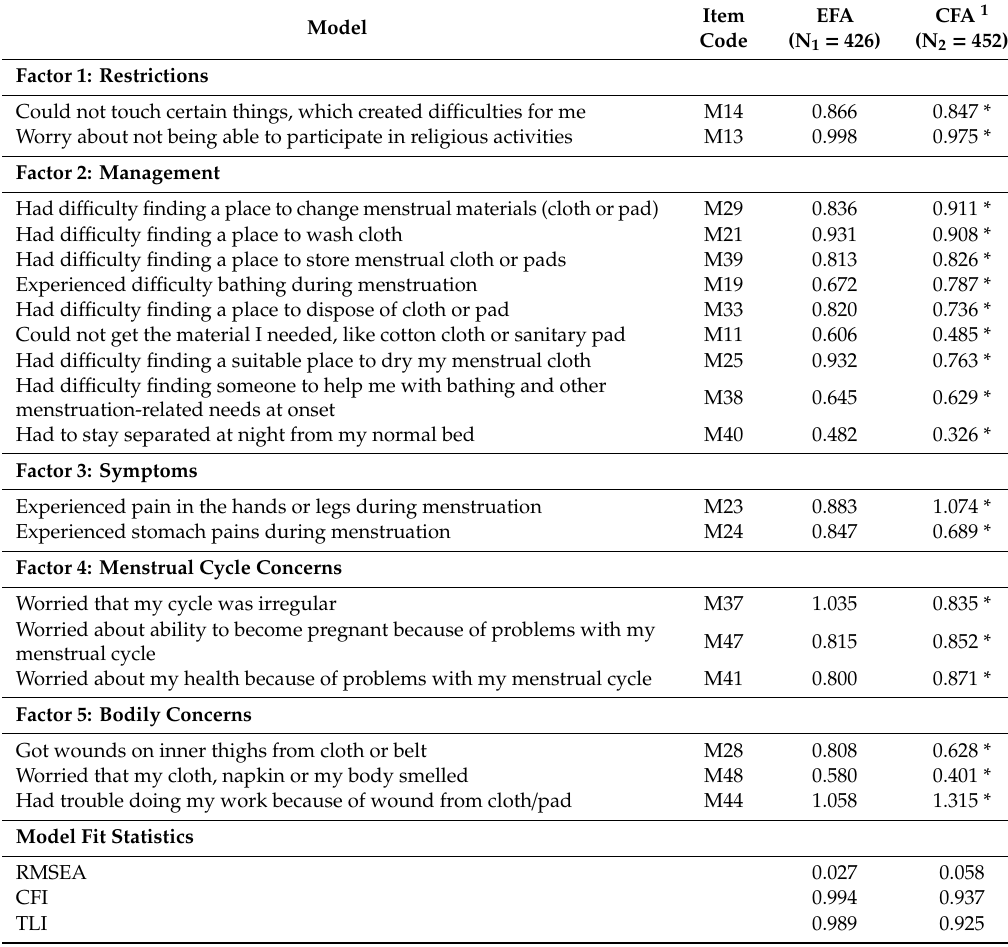
Table 3. Final factor loadings and model fit statistics for random split-half sample EFA (N1 = 426) and CFA models (N2 =